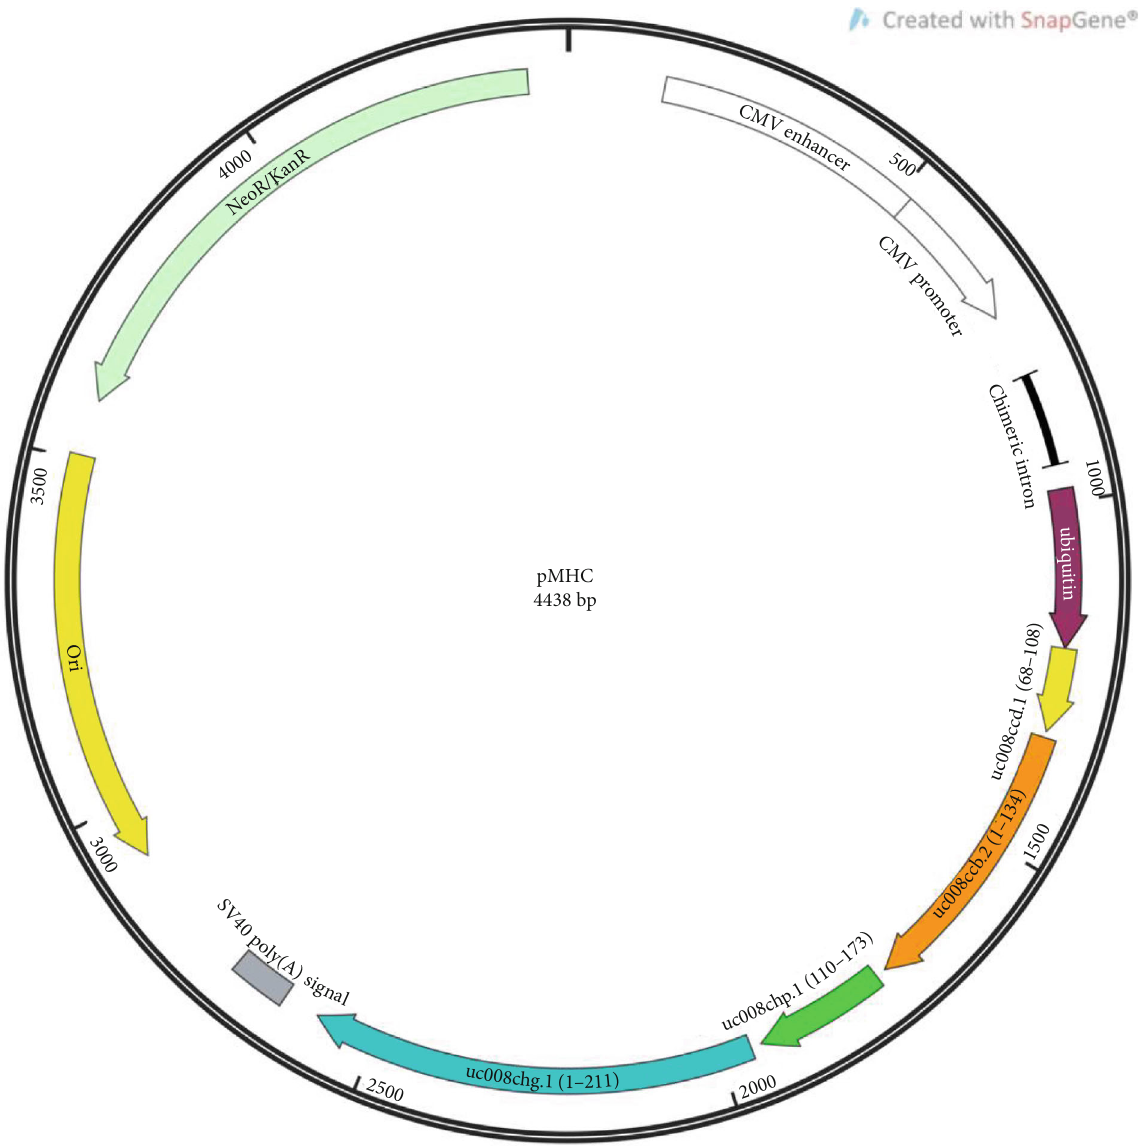
Figure 1: pMHC plasmid